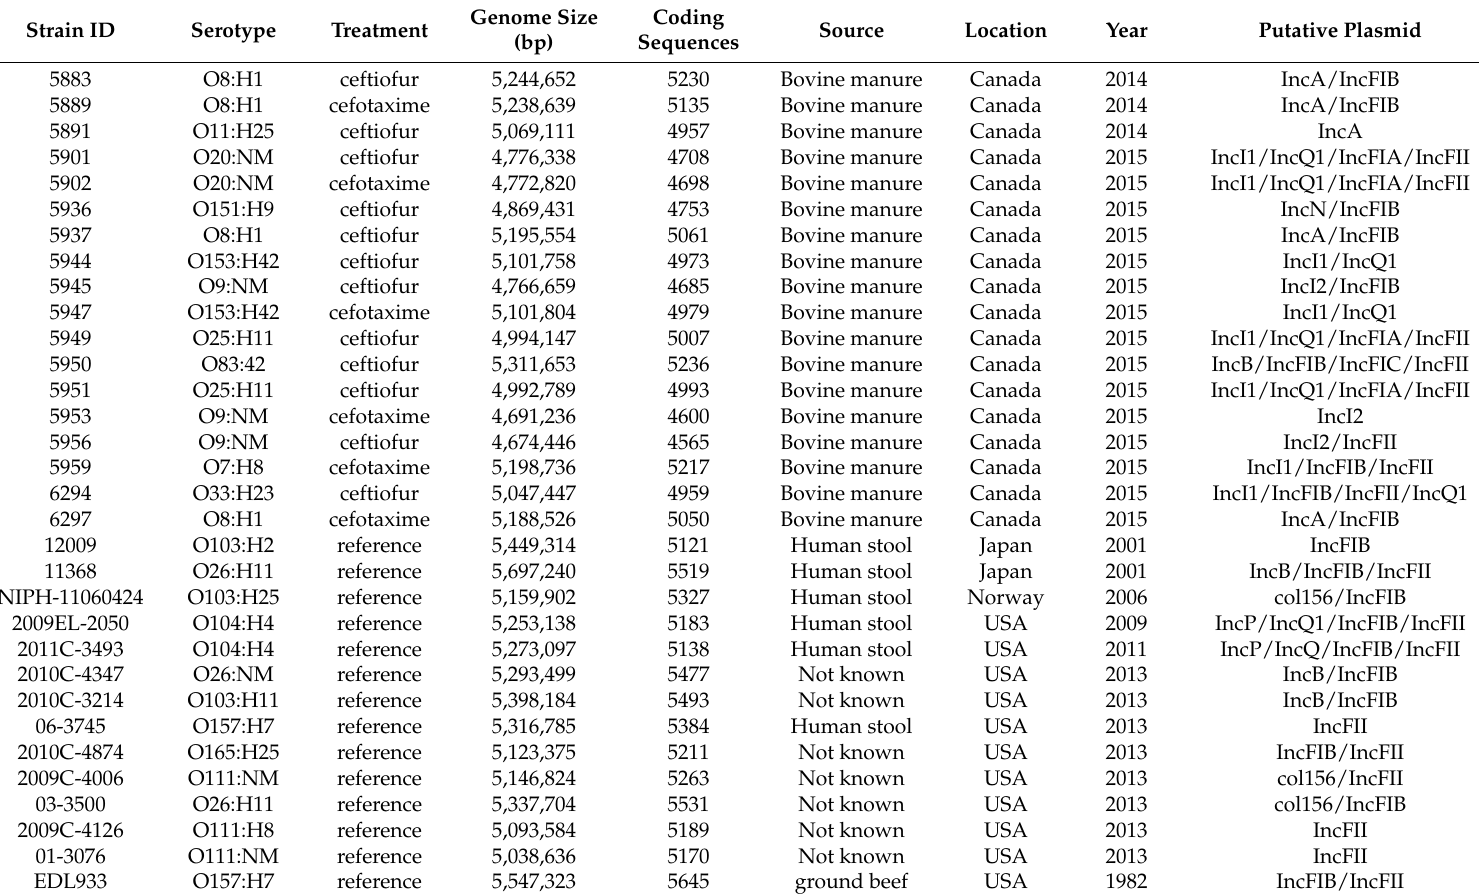
Table 2. Characteristics of the 32 isolates used in this